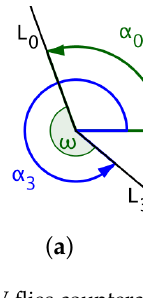
Figure 7. ( a ) UAV flies counterclockwise where α 0 < α 3 ; ( b ) UAV flies counterclockwise where α 0 > α 3 .